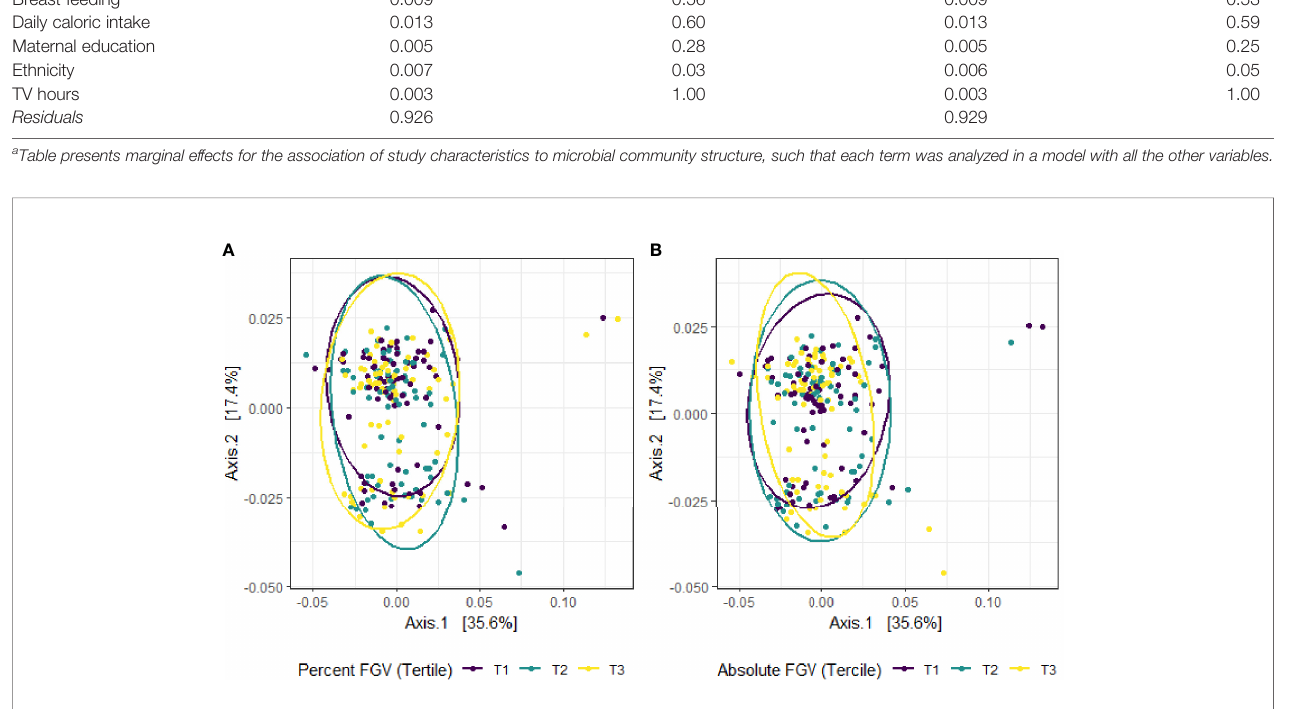
FIGURE 4 | Principal coordinate analysis (PCoA) plot of predicted MetaCyc pathway abundance derived from Bray-Curtis dissimilarity among fecal samples provided by 218 girls in GOCS colored by %FGV (A) and aFGV (B) terciles. Ellipses are 95% con fi dence regions for each tercile.